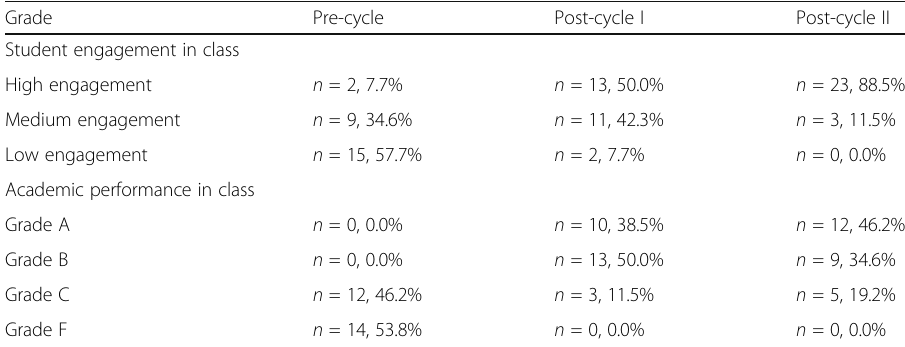
cycles of action